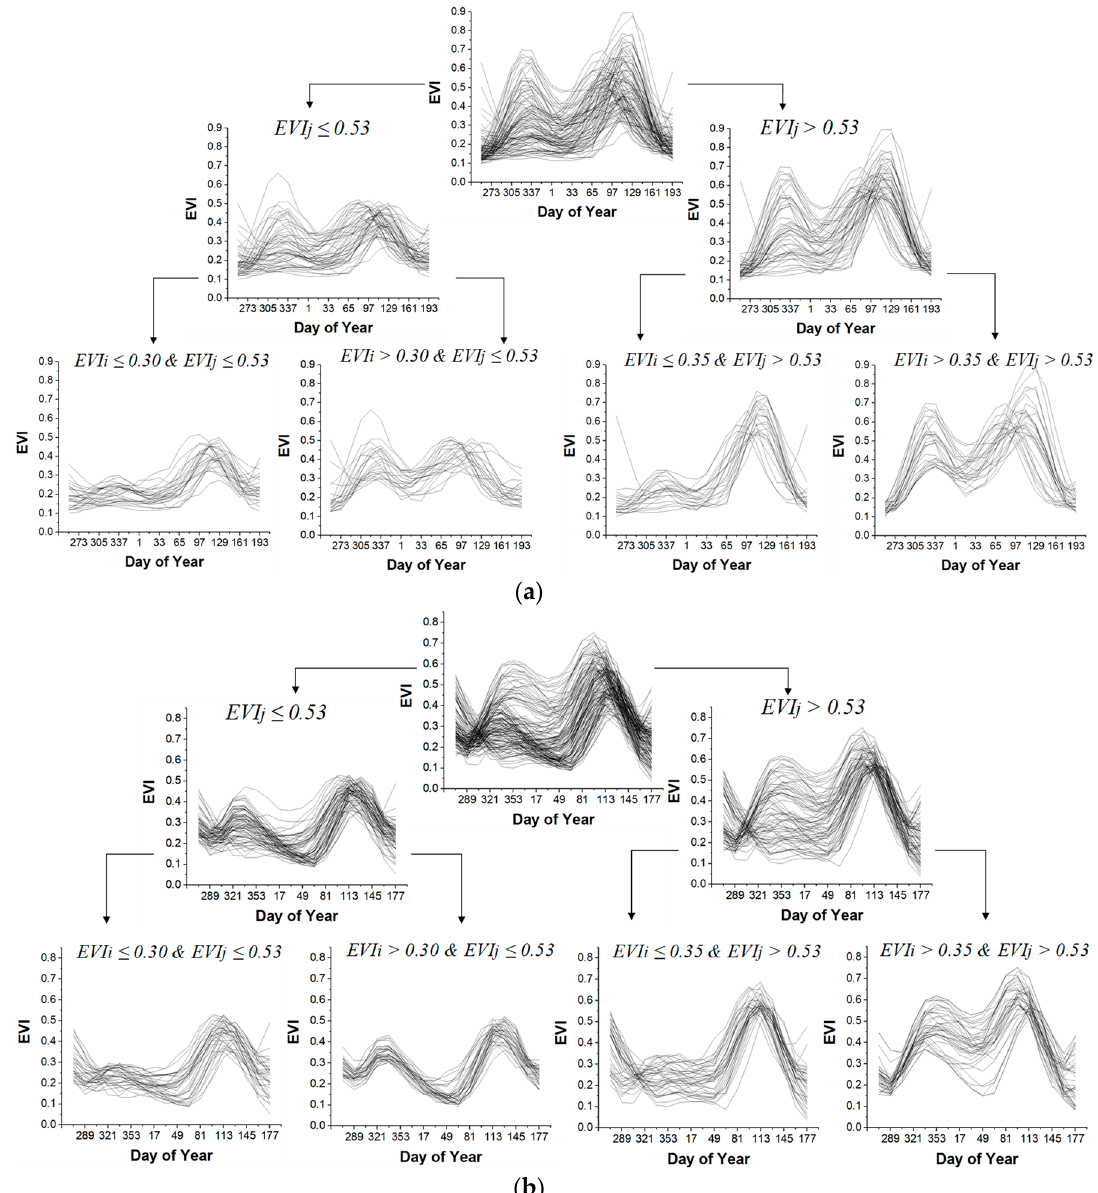
Figure 4. EVI curves of training samples. ( a ) Kansas. ( b ) NCP. EVI i and EVI j are the first and second peaks of EVI time series, respectively .